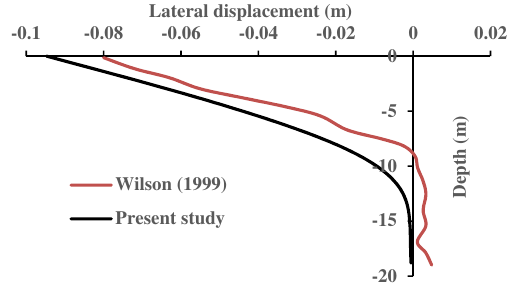
Fig. 7 Comparison of lateral displacement profile obtained from present study with dynamic centrifuge tests